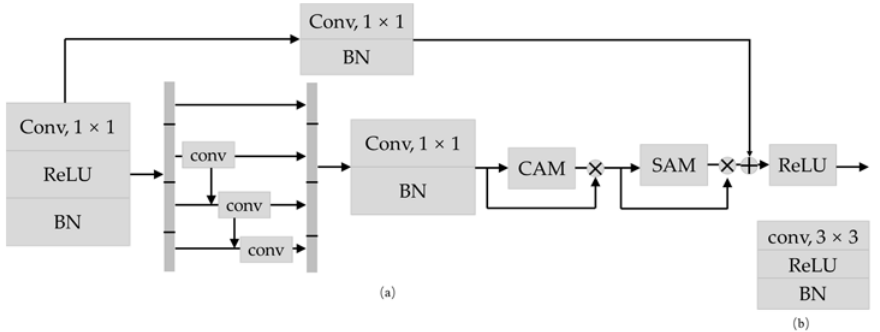
Figure 10. Illustrations of Conv Block and Identify Block. ( a ) The main structure of Conv Block and Identify Block: CAM refers to the CAM block; SAM stands for the SAM block. The details of conv used in figure ( a ) are illustrated in ( b ).